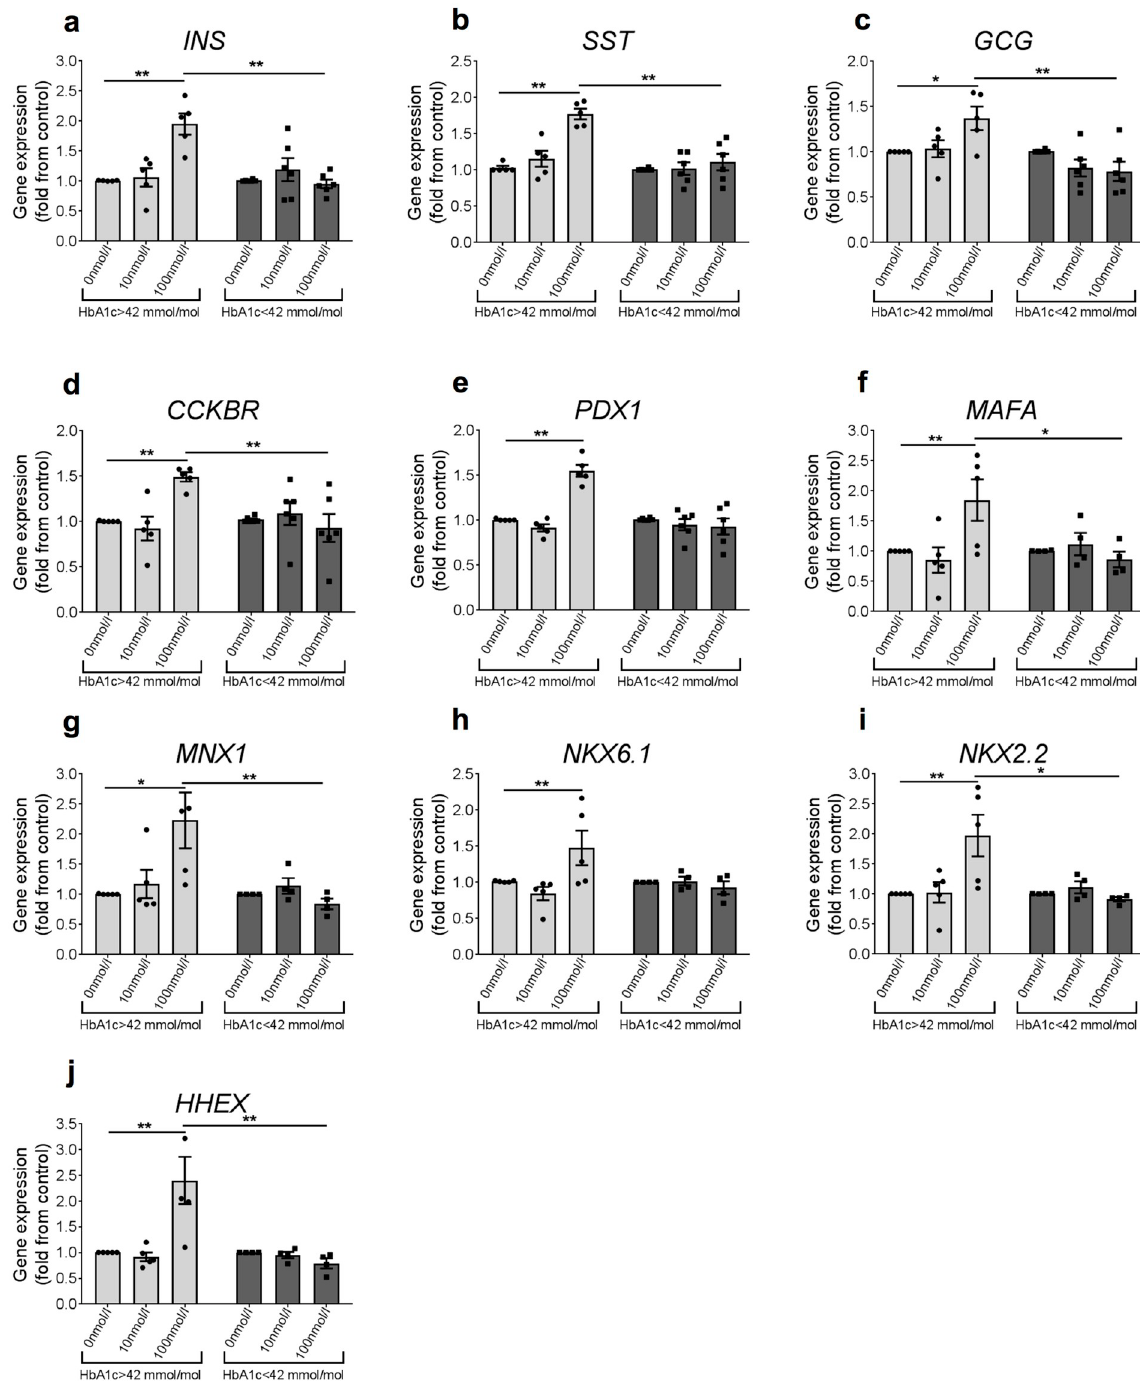
Fig 2. Gastrin enhances transcription of genes involved in islet cell function and identity in donors with higher HbA 1c levels. a-j. Isolated human islets were incubated with increasing doses (0, 10 and 100 nmol/l) of gastrin and cultured for 48 h before qRT-PCR analysis. Data represent mean ± SEM from a total of 5–6 independent donors of lower and higher HbA1c, respectively. A 2-way ANOVA followed by a Tukey multiple comparison posttest statistical analysis was performed to determine significance. � p < 0.05, �� p < 0.005.